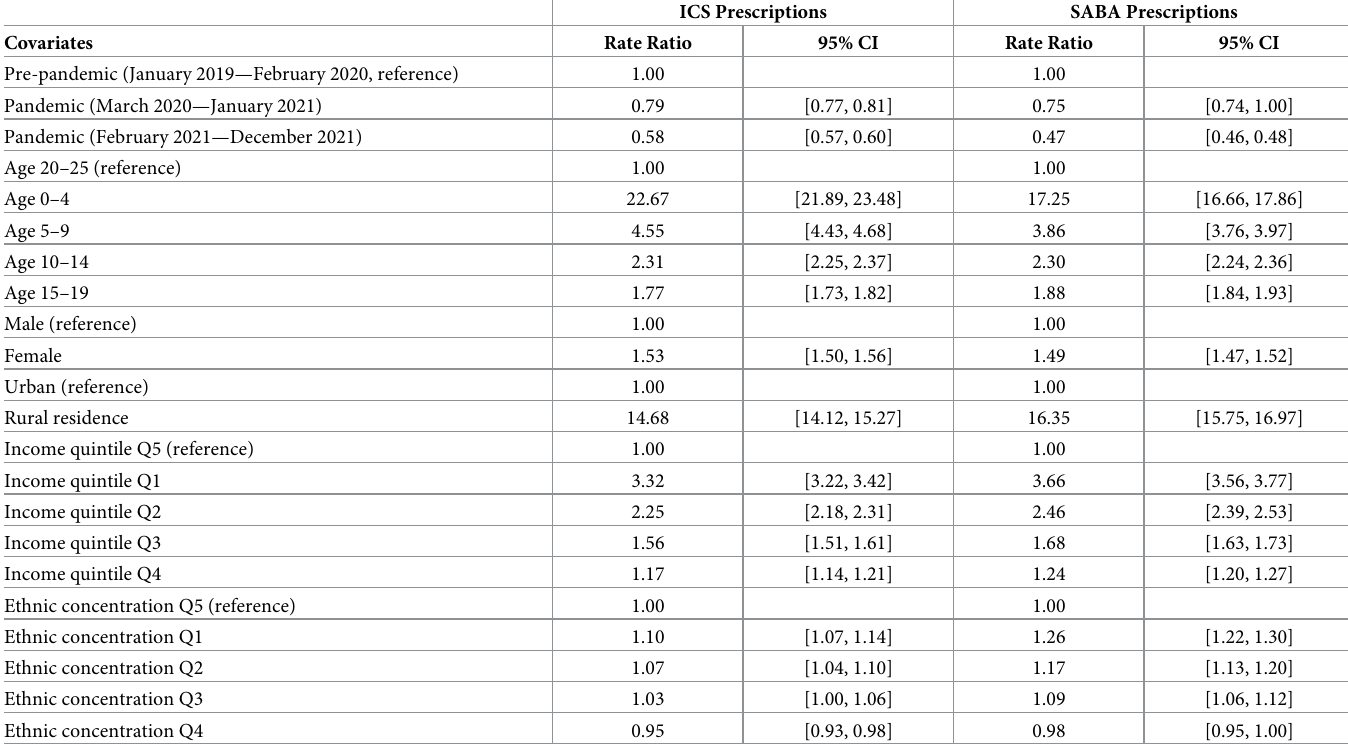
Table 3. Adjusted rate ratios of asthma prescription medication based on negative binomial